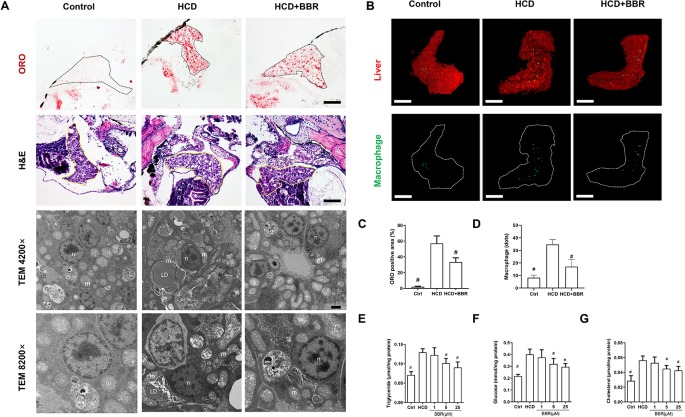
Effects of berberine (BBR) on hepatic steatosis in high-cholesterol diet (HCD)-induced zebrafish larvae. (A) The zebrafish larvae were treated with the control diet, HCD diet, and HCD plus BBR (5 μM) treatment. Hepatic steatosis was observed by whole-body Oil Red O (ORO) staining (line 1, refer to the black dotted, bar = 100 μm), H&E staining (line 2, refer to the yellow dotted, bar = 100 μm), and TEM (line 3, bar = 2μm; line 4, bar = 1 μm). m mitochondrion, n cell nucleus, LD lipid droplet. (B) L-plastin-labeled macrophages in Tg (fabp10a: dsRed) zebrafish. The statistical results of the positive area of ORO staining were shown in (C) and the quantity of macrophage in the liver of larval zebrafish in (D). Effects of BBR on the levels of triglyceride (E), glucose (F), and cholesterol (G) in livers of zebrafish larvae fed with HCD. #Compared with the HCD group, P < 0.05.